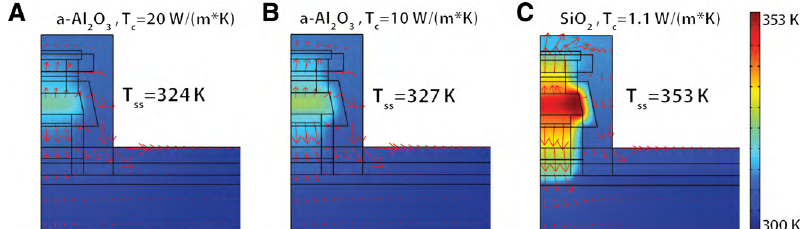
and heat flux (indicated by the red arrows) of the designed device, ss O shield with medium literature 2 3 shield with well-calibrated literature thermal conductivity value of 1.1 W/(m·K). 2